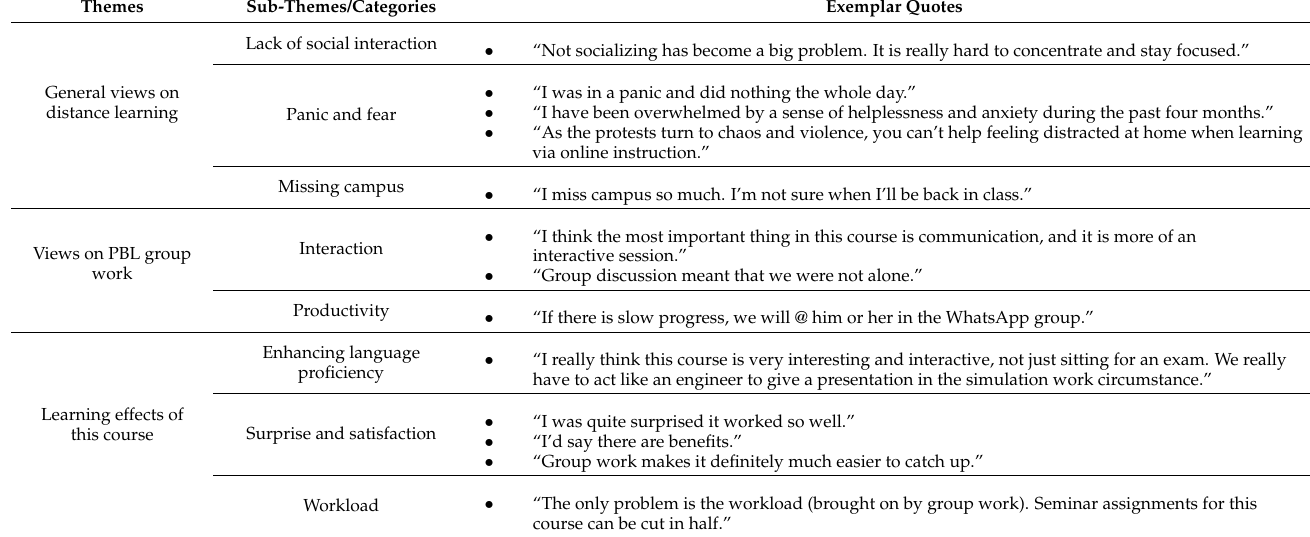
Table 7. Thematic analysis of focus group